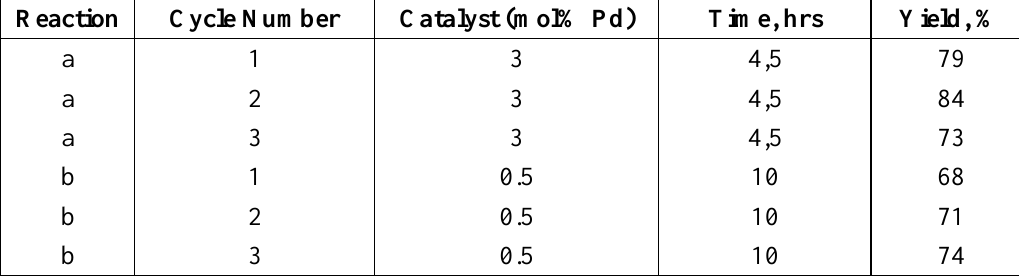
Table 2. Fresh start of the heterocyclization